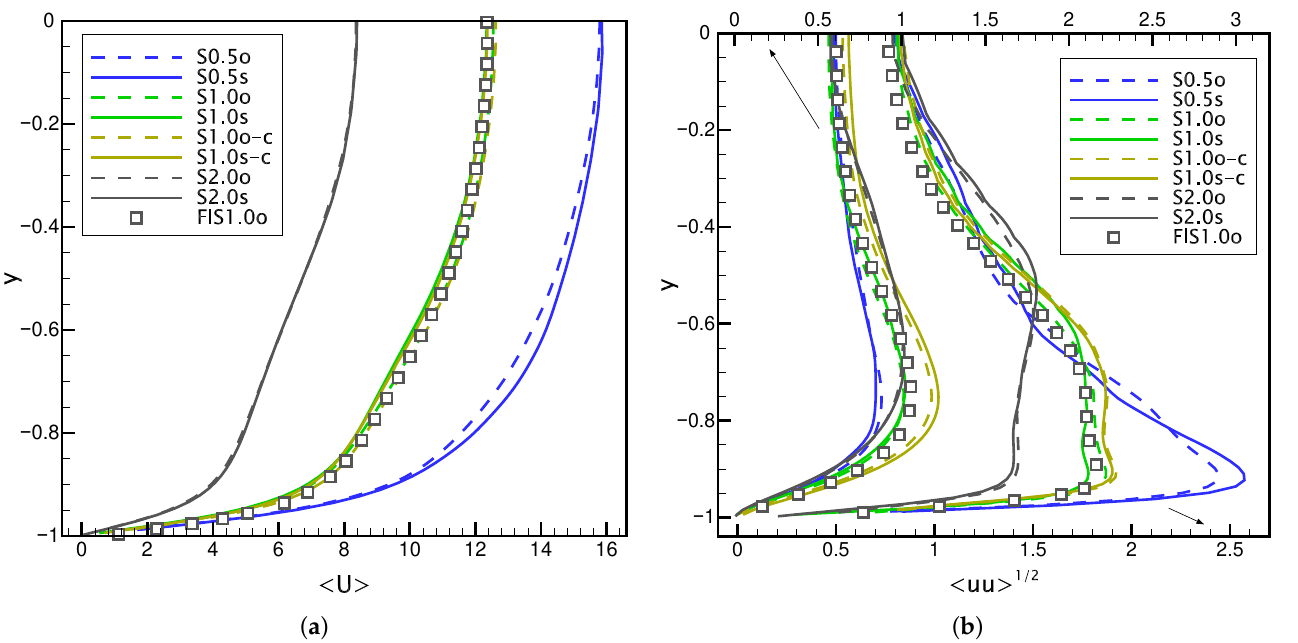
Figure 8. Profiles of the time-averaged streamwise velocity ( a ) and the profiles of the fluctuations of the streamwise and wall-normal velocity components ( b ) along the channel height at x =